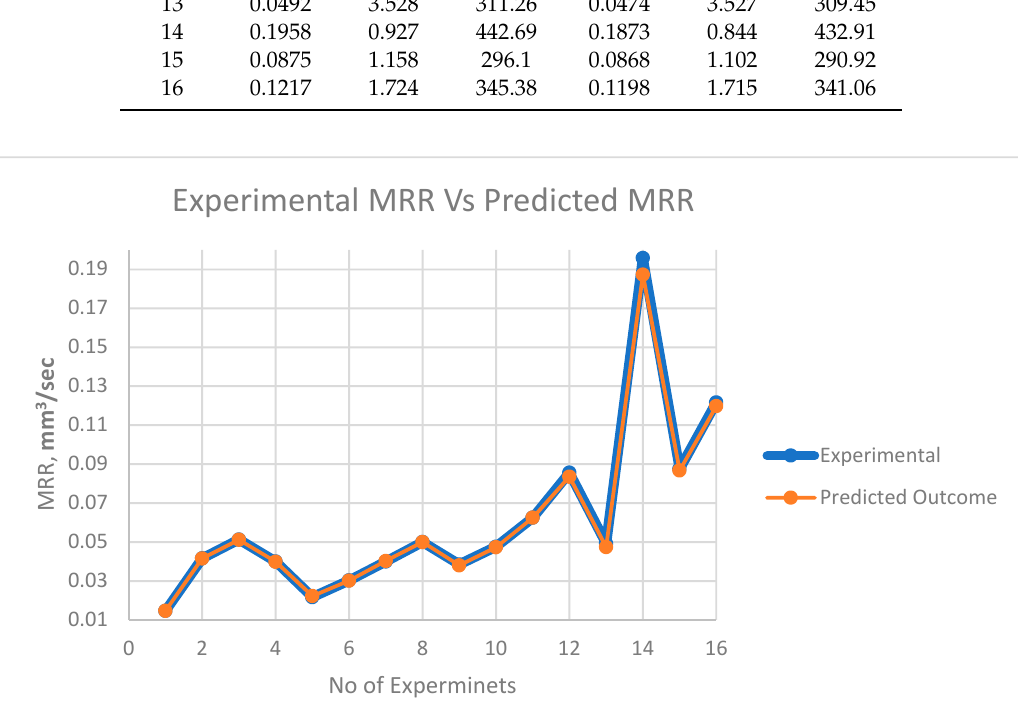
Figure 8. Plot of experimental MRR vs. predicted MRR.